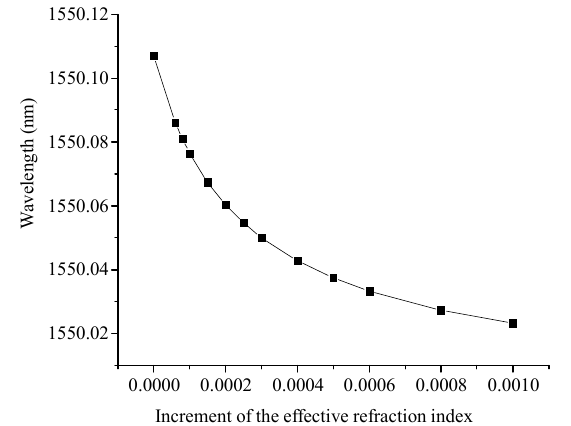
Fig. 5 Wavelength response curve in a symmetrical perturbation.